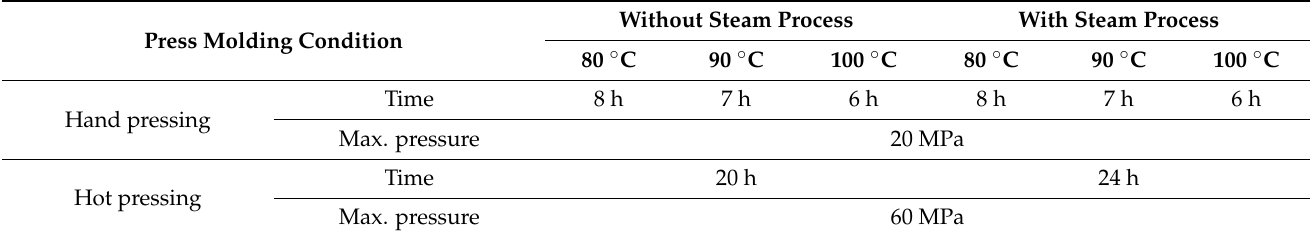
Table 1. Pressing condition of nanocellulose bulk material